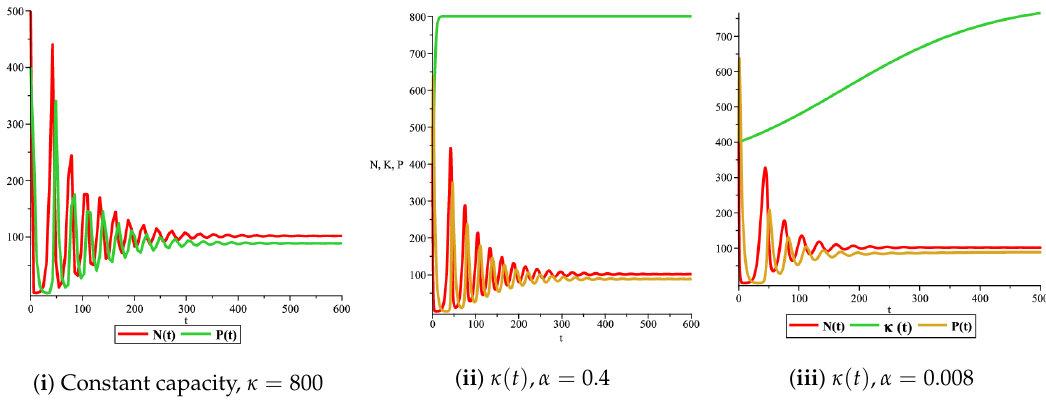
Figure 8. Effect of logistic carrying capacity on prey–predator model with Holling type II functional response, κ 1 = 300, κ 2 = 500, r = c = 0.25, a = b = 0.0025, γ =